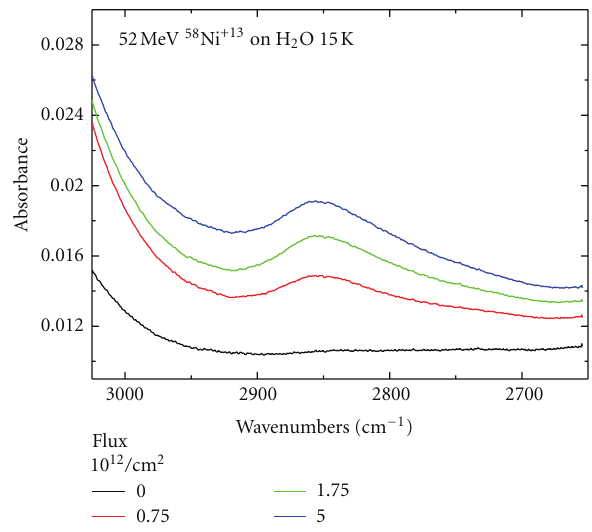
Figure 2: IR spectra (shifted for clarity) of H 2 O ice as deposited and after irradiation with 200 keV He + at 77K. It is clear that the appearance, upon irradiation, of a band at about 2850 cm − 1 is easily attributed to H 2 O 2 .